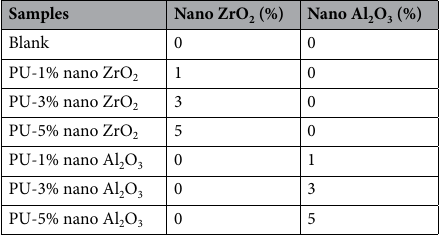
Table 1. Polyurethane power coatings nanocomposite